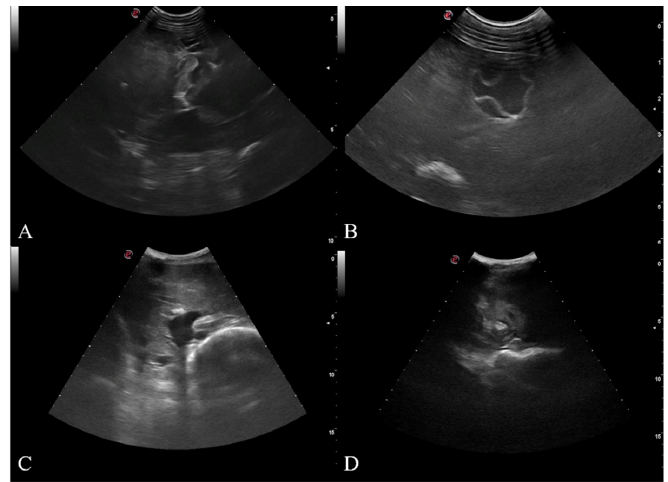
Figure 4. Liver lesion detected through US: ( A ) CE2, multivesicular, multiseptated cysts, active; ( B ) CE3, unilocular cyst, with detachment of laminated membrane from cyst wall, could contain daughter cysts, transitional; ( C ) CE5, thick calcified wall that is arch shaped, producing a cone shaped shadow, inactive; ( D ) liver abscess.